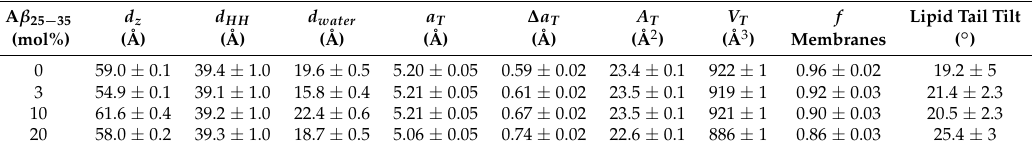
Table 1. Structural membrane parameters for the different amyloid β 25 − 35 concentrations. While the lamellar d z -spacing changes with peptide concentration, the head group-head group distance d HH is constant such that changes can be attributed to changes in the water layer thickness, d water . Distance between acyl chains ( a T ), area per tail ( A T ) and tail volume ( V T ) continuously decrease with increasing peptide concentration while the disorder in tail packing increases ( ∆ a T ). The membrane orientation parameter, f , decreases and lipid tilt angles increase, indicating and increasing distortion and bending of the bilayers with increasing peptides concentration. (Values from